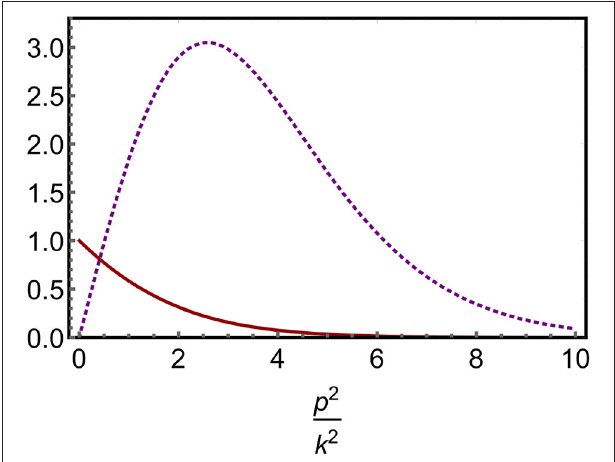
FIGURE 7 | The regulator R k ( p 2 ) (continuous red line) acts as a suppression term for IR modes. In the flow equation Equation (43) its derivative with respect to k (dotted purple line) acts as a suppression for UV modes, as well, such that the main contribution to the scale dependence of the dynamics at k comes from modes at that momentum